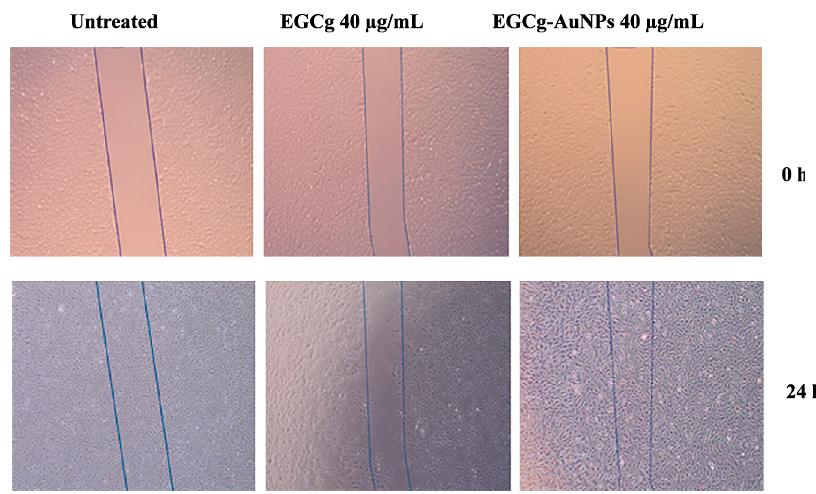
Figure 10. Inhibitory effects of EGCg-AuNPs and free EGCg on human coronary artery smooth muscles cell (HCASMCs) migration. Images were captured at 4× magnification.